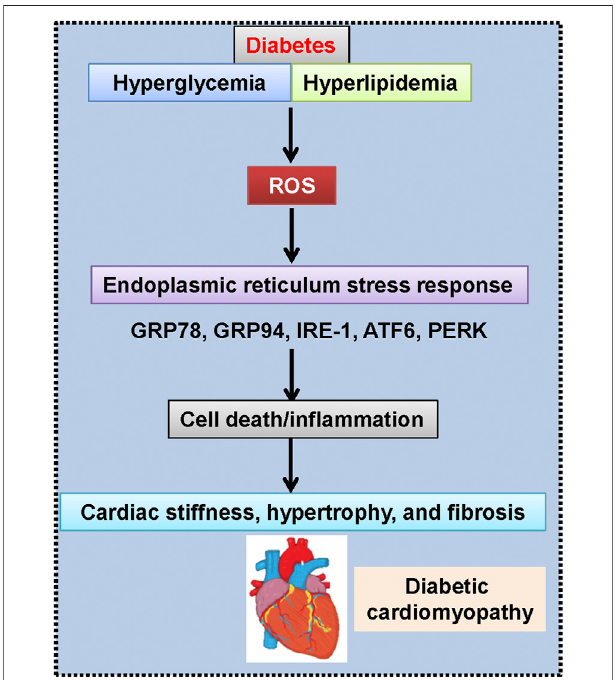
FIGURE 4 | Engagement of endoplasmic reticulum stress in diabetic cardiomyopathy. ATF6, activating transcription factor 6; GRP78, glucose- regulated protein-78; GRP94, glucose-regulated protein-94; IRE-1, inositol- requiringkinase-1;PERK,proteinkinaseR-likeERkinase;ROS,reactive oxygen